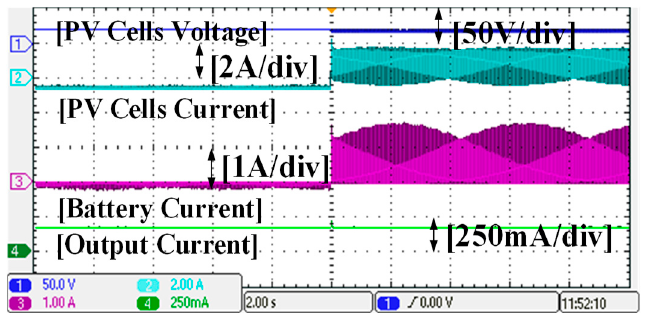
Figure 15. DISO mode switches to SIDO mode.